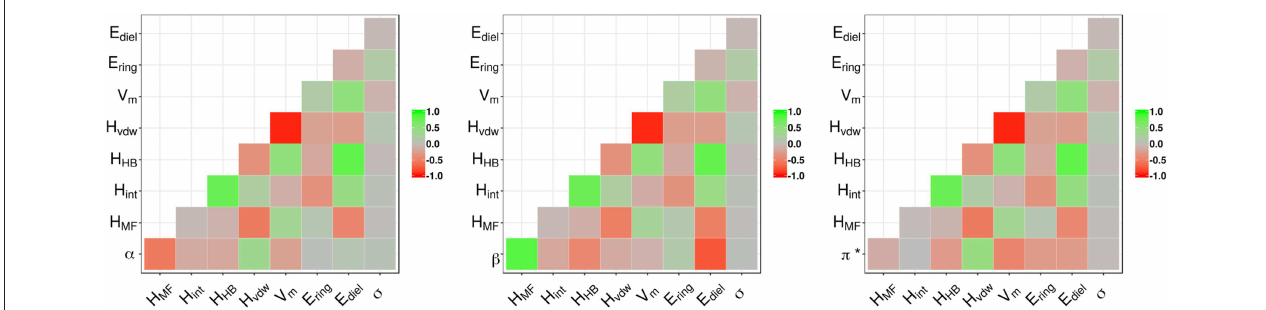
FIGURE 2 | Correlation plots of α , β , and π ∗ with the COSMO-RS calculated parameters.